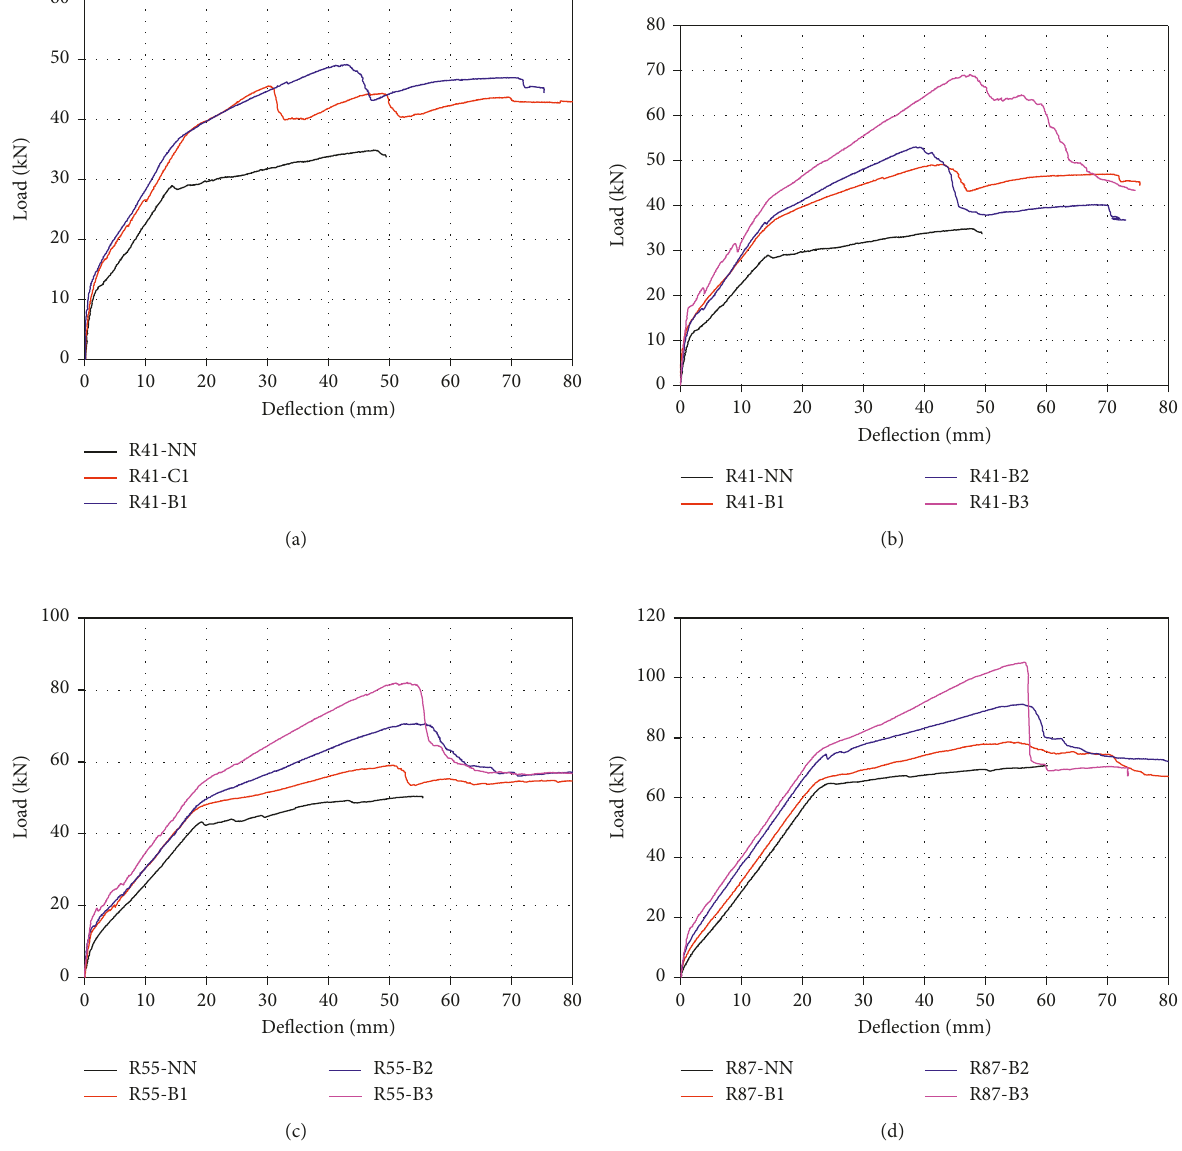
Figure 6: Comparison of load-deflection curves. (a) Specimens with CFRP and BFRP fabric. (b) Specimens with the tensile re- inforcement ratio of 41%. (c) Specimens with the tensile reinforcement ratio of 55%. (d) Specimens with the tensile reinforcement ratio of